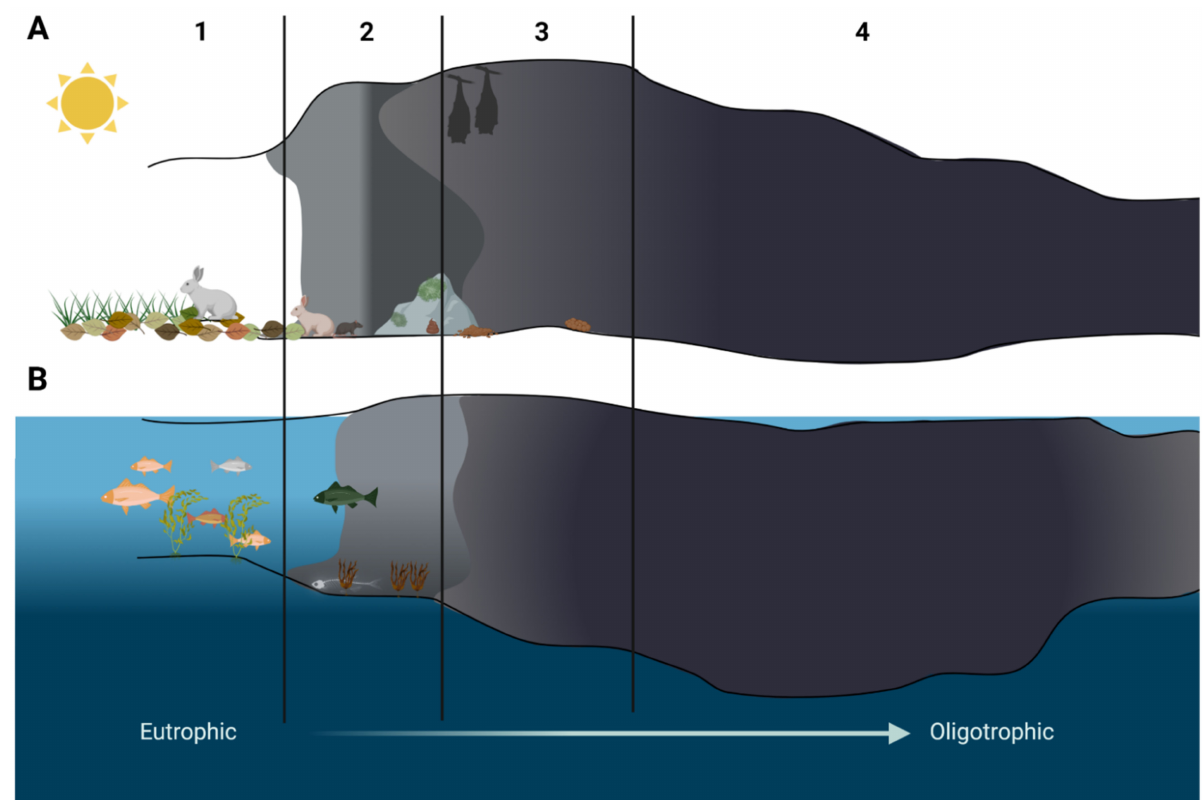
Figure 2. Schematic representation of cave zones in ground ( A ) and anchialine ( B ) caves. 1—entrance zone, 2—twilight zone, 3—transition zone, 4—dark zone. Source: Ghosh at al., 2017 (modified) and Calder ó n-Guti é rrez et al., 2018 (modified). Created with BioRender.com (accessed on 4 January